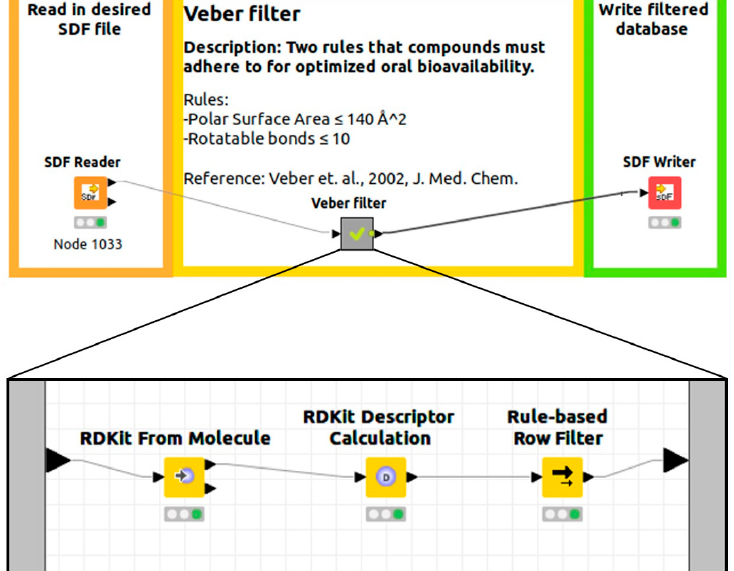
Figure 7. KNIME workflow example of our Veber filter implementation for effective design of compound libraries. Black lines represent the expanded meta node that contains sub-nodes [51].